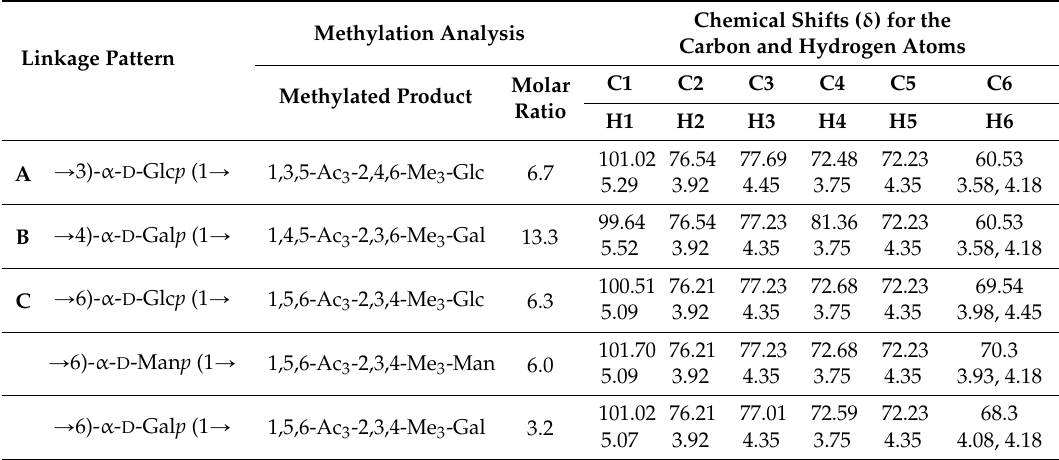
Table 1. Methylation analysis of BAGP33 and the NMR spectrum signals assigned for AGP33